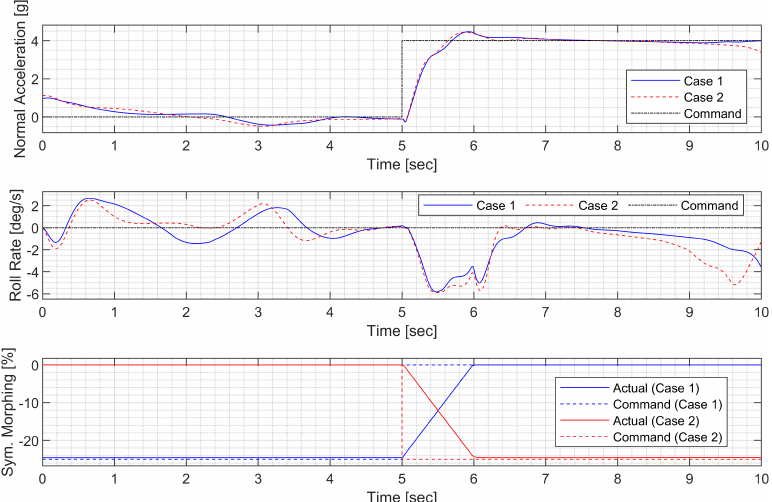
Figure 11. Controlled states and symmetric morphing parameter history for the push-over and pull-up (LPV).